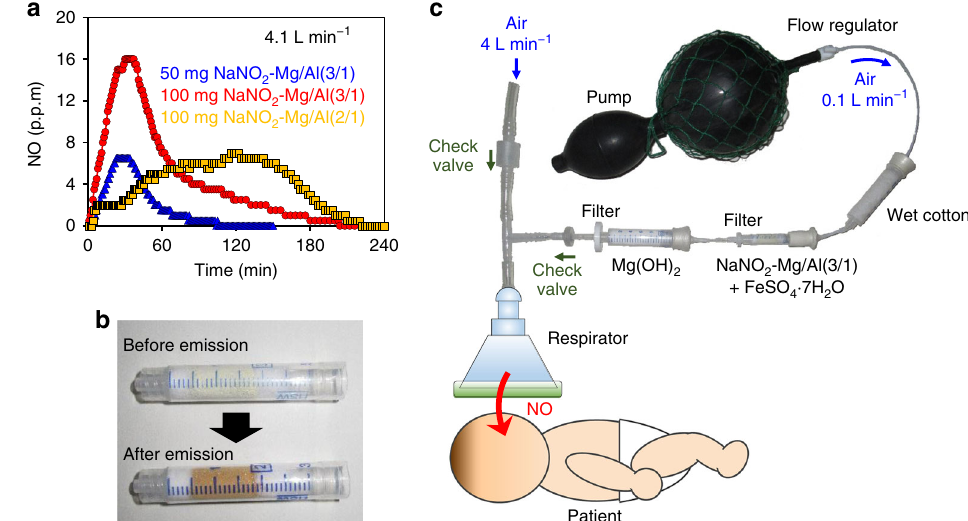
Fig. 5 Battery-free respirator for inhaled NO. a Concentration of NO released from the mixture of NO 2 − -incorporated LDH and 10 equivalent (in weight) of FeSO 4 ∙ 7H 2 O under 4.1 L min − 1 air. See Supplementary Fig. 5 for experimental set-up. b Photograph of NaNO 2 -Mg/Al(3/1) and FeSO 4 ∙ 7H 2 O mixture before and after ending of NO release. c Prototype portable and battery-free respirator for inhaled